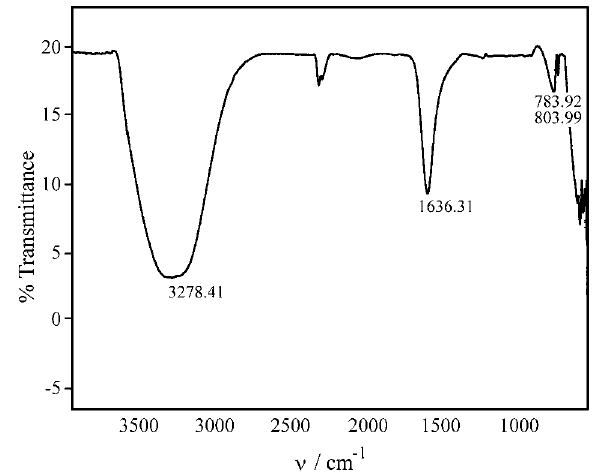
Figura 5a. Espectro IR característico de una disolución de 0.2 M de SnCl 2 , correspondiente a la muestra líquida obtenida del filtrado del sistema SnCl 2 -NH 4 OH-H 2 O a pH 1.85.